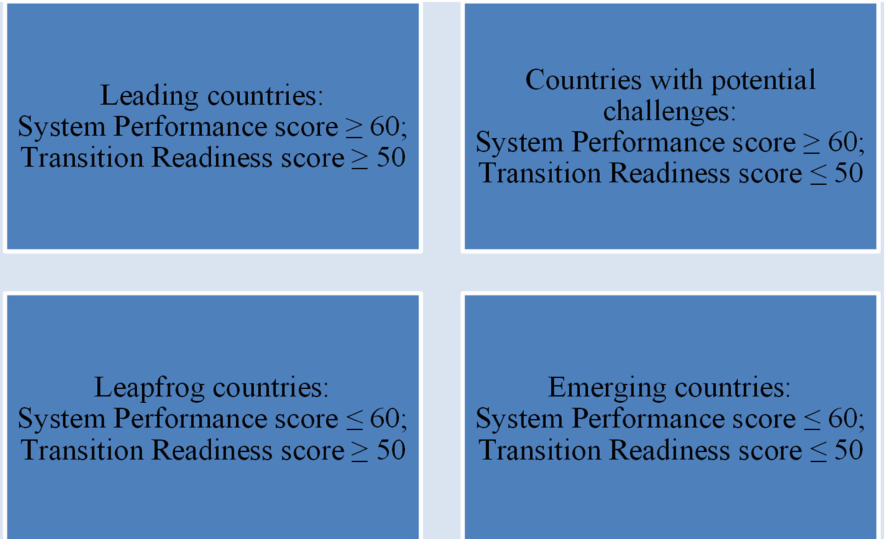
Figure 2. Categories of countries with two dimensions of the TSI. Source: authors based on Singh et al., (2019)